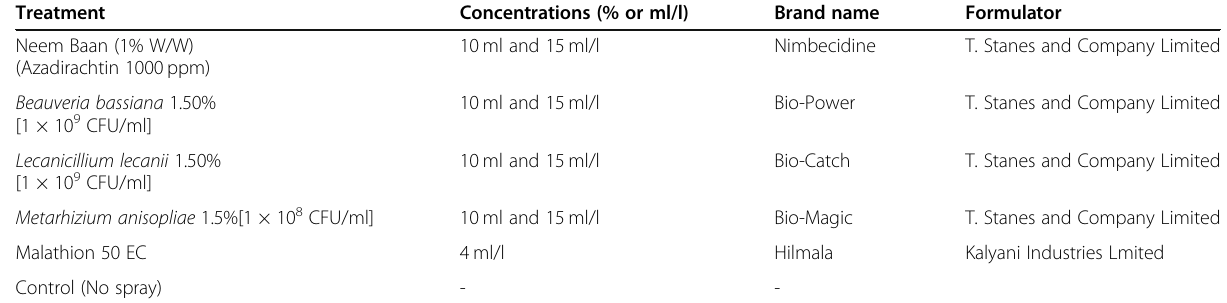
Table 1 Biopesticides evaluated against Bemisia tabaci on cucumber under net house conditions